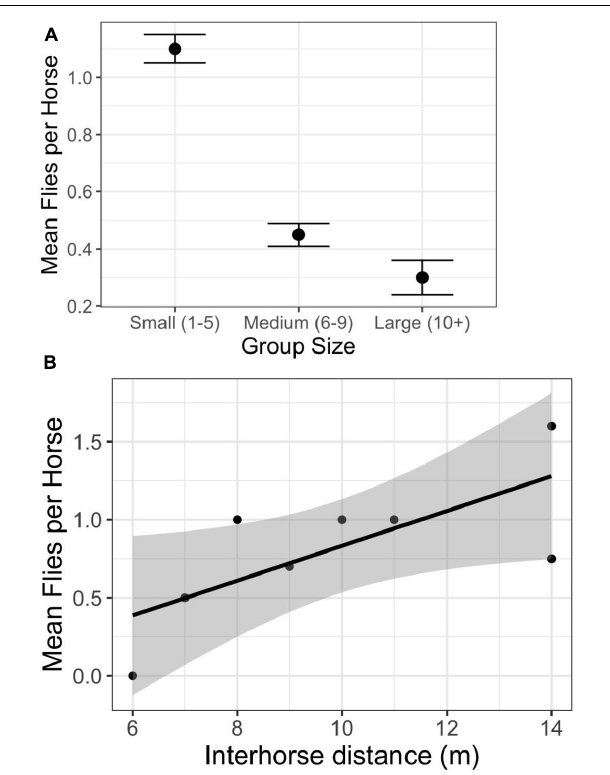
FIGURE 3 | Relationship between per capita fly numbers and social factors. (A) The relationship between group size and the average number of flies hovering over, or landing on, individual horses ( F 2 , 935 = 64.9; p < 0.0001). (B) The relationship between the average number of flies hovering over, or landing on, individual horses as a function of the average distance between two horses within groups ( y = 0.53 + 0.12*X; F 1 , 761 = 37.61; p <